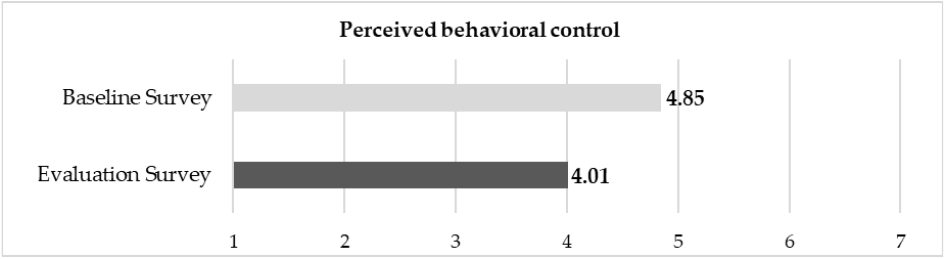
Figure 8. A comparison of the energy-saving–comfort trade-off in Greek public buildings (before and after the trial).